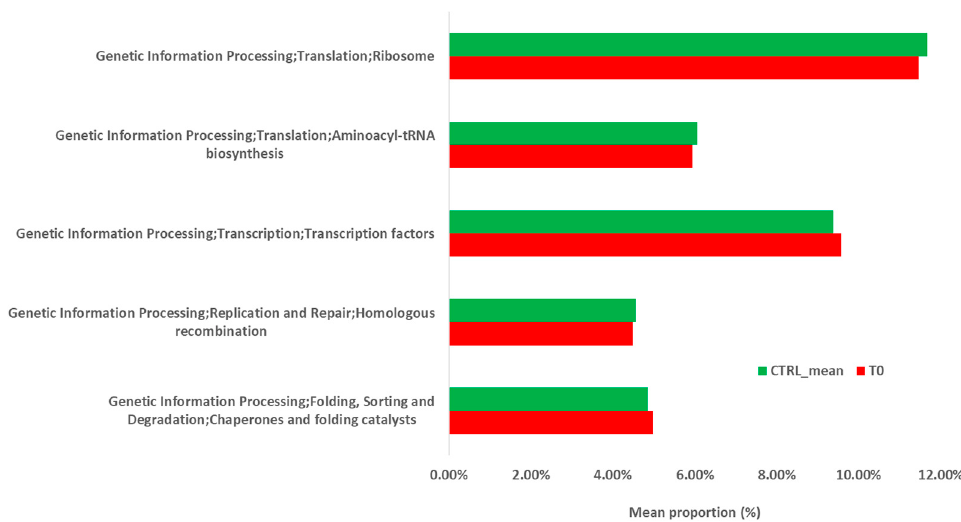
Figure 9. Predicted functional pathways (KEGG Level III) of the gut microbiota during infection (T 0 ) with S. stercolaris .